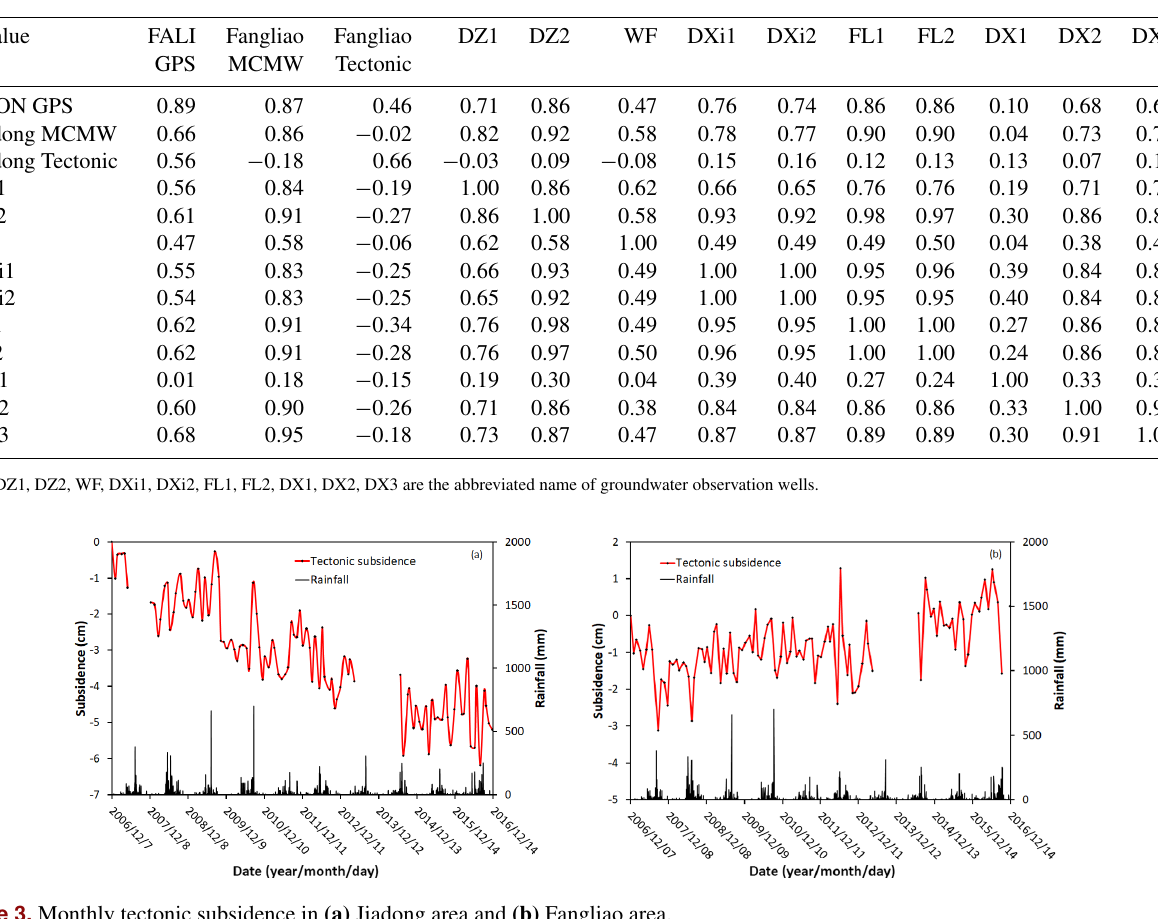
Figure 3. Monthly tectonic subsidence in (a) Jiadong area and (b) Fangliao